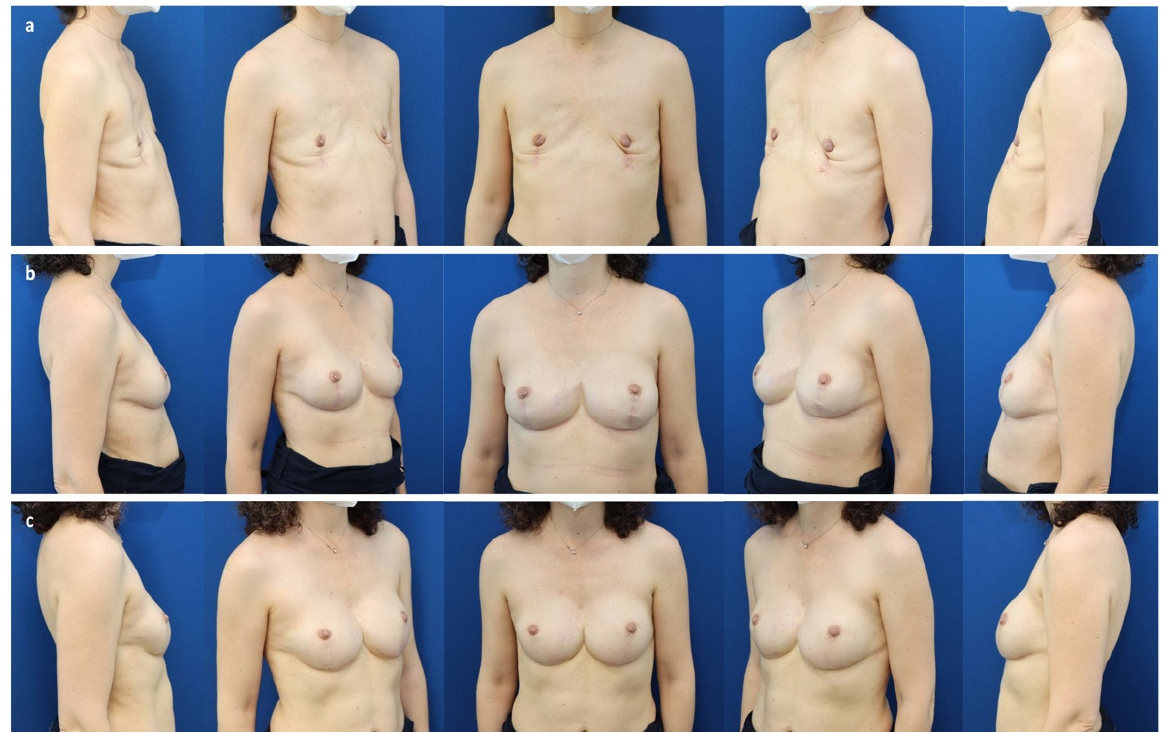
Figure 6. ( a ) A 44-year-old patient with mild structural deformity of the anterior chest wall and state after bilateral implant-removal for infection following a nipple-sparing mastectomy and immediate subpectoral implant-based reconstruction elsewhere for multifocal invasive-ductal carcinoma (pT2 pN 1a (3/3) M0) associated with an extended in situ component of the right breast and BRCA-2 mutation. ( b ) Three months after completed expansion (Motiva Flora ® XMF-58 440 cc) and before the first session of autologous fat grafting. ( c ) One year after the expander-to-implant based prepectoral breast reconstruction and two sessions of autologous fat grafting (70–90 cc per breast: reversed expansion, “hybrid breast reconstruction”; Motiva Ergonomix ® ERSM 275 cc).